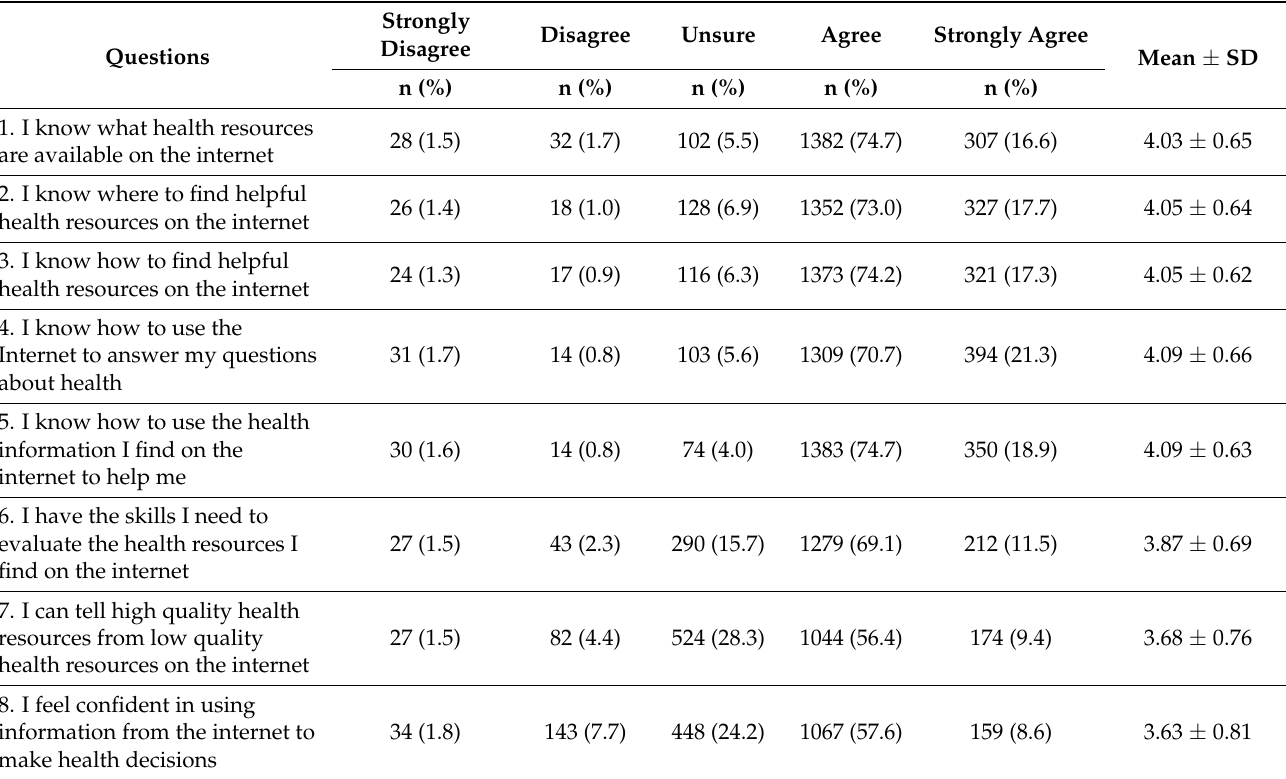
Table 2. Responses of eHealth literacy scale (n = 1851).